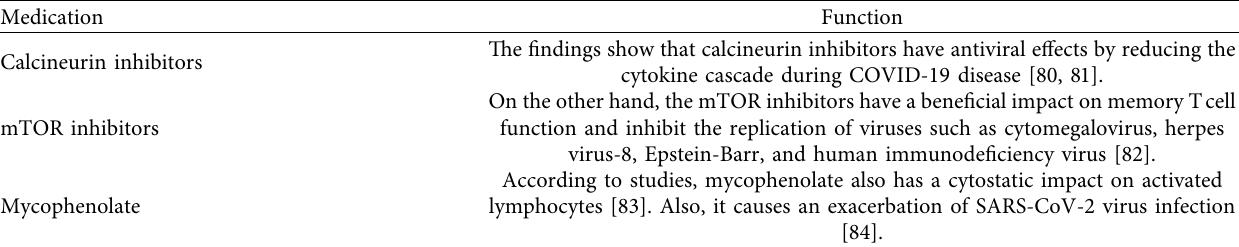
Table 1: Te role of inhibitory medications in liver transplantation